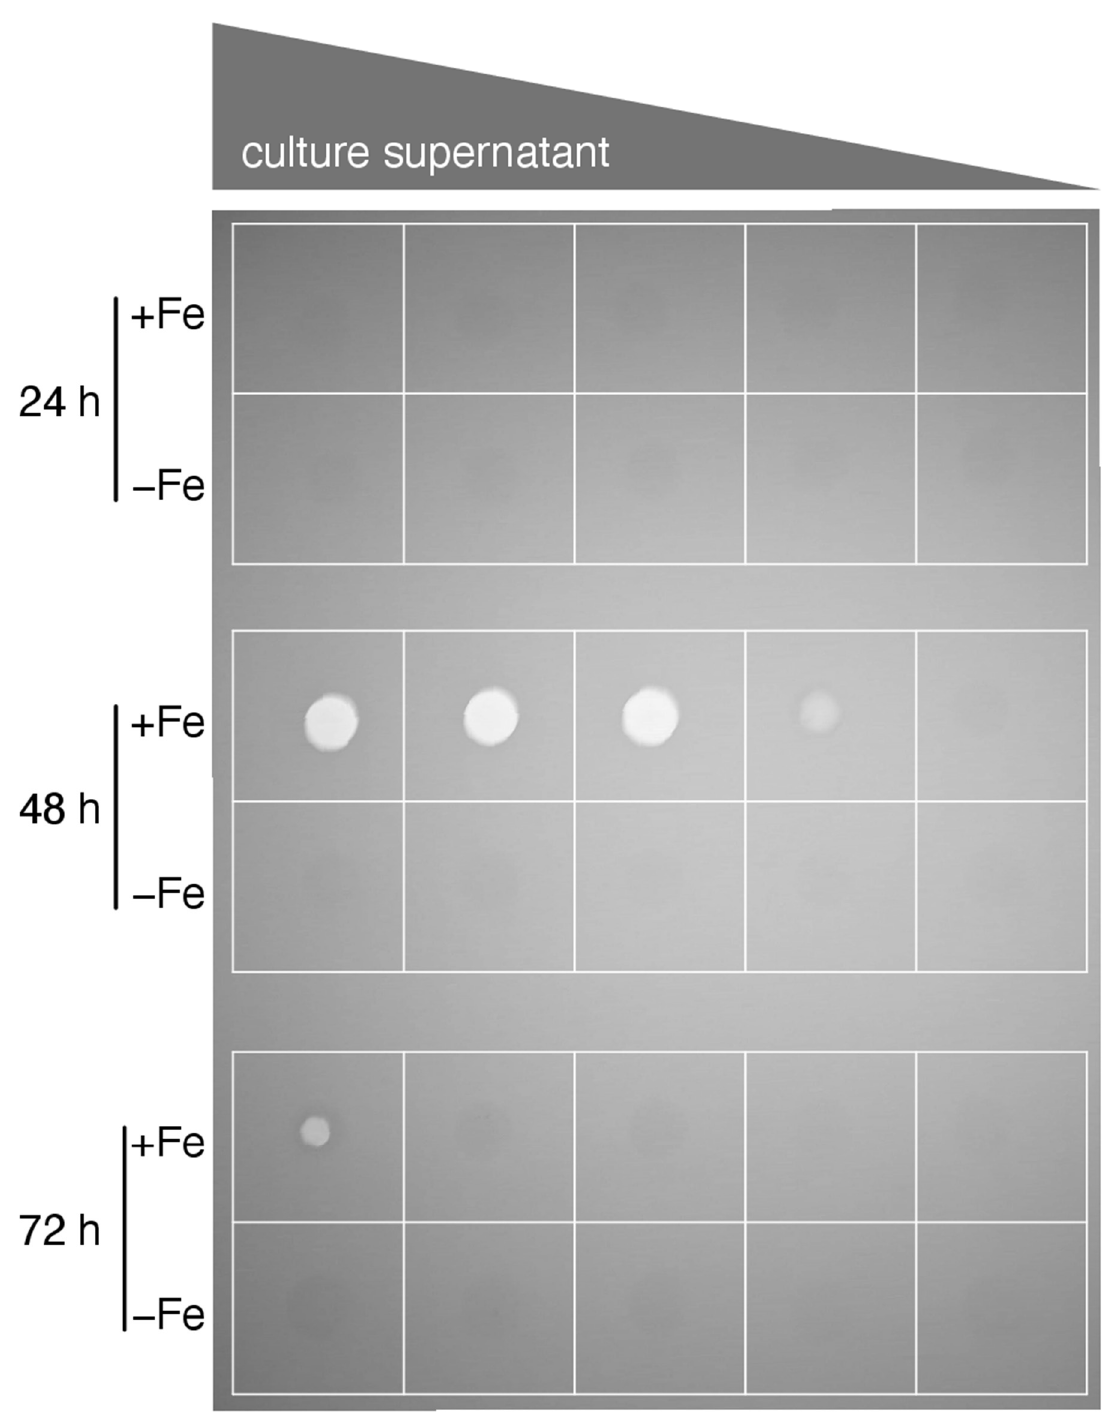
Figure 3. Protease activity is detectable in culture supernatants of +Fe cultures at 48 h and to a lesser extent in 72 h but not in those of younger (24 h) +Fe or in − Fe cultures. Supernatants from cultures were spotted onto an unprocessed X-ray film to test for the presence of proteolytic activities that hydrolyze the gelatin-containing light-sensitive layer (visible as bright circles). Two-fold dilution series (1:1–1:16) in PBS is indicated on top of the picture. The decrease of proteolytic activity in 72 h +Fe compared to 48 h +Fe cultures is most likely caused by degradation of the